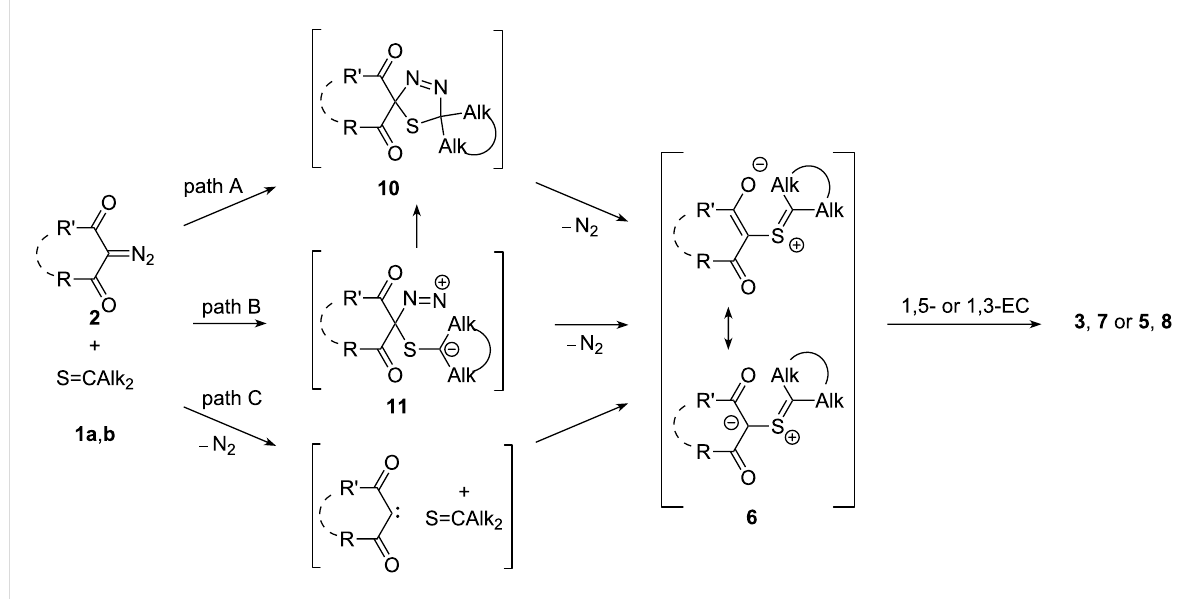
Scheme 2: Three possible pathways A , B and C for the formation of 1,3-oxathioles 3 , 7 and thiiranes 5 and 8 from diazodicarbonyl compounds 2 and thioketones 1 .